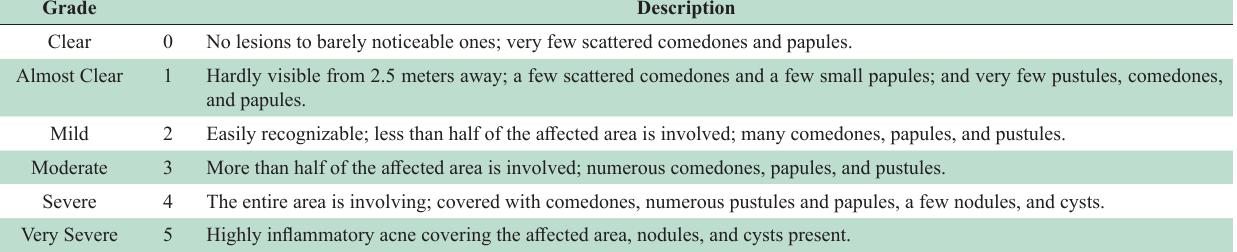
Table-I: Comprehensive Acne Severity Scale (CASS).